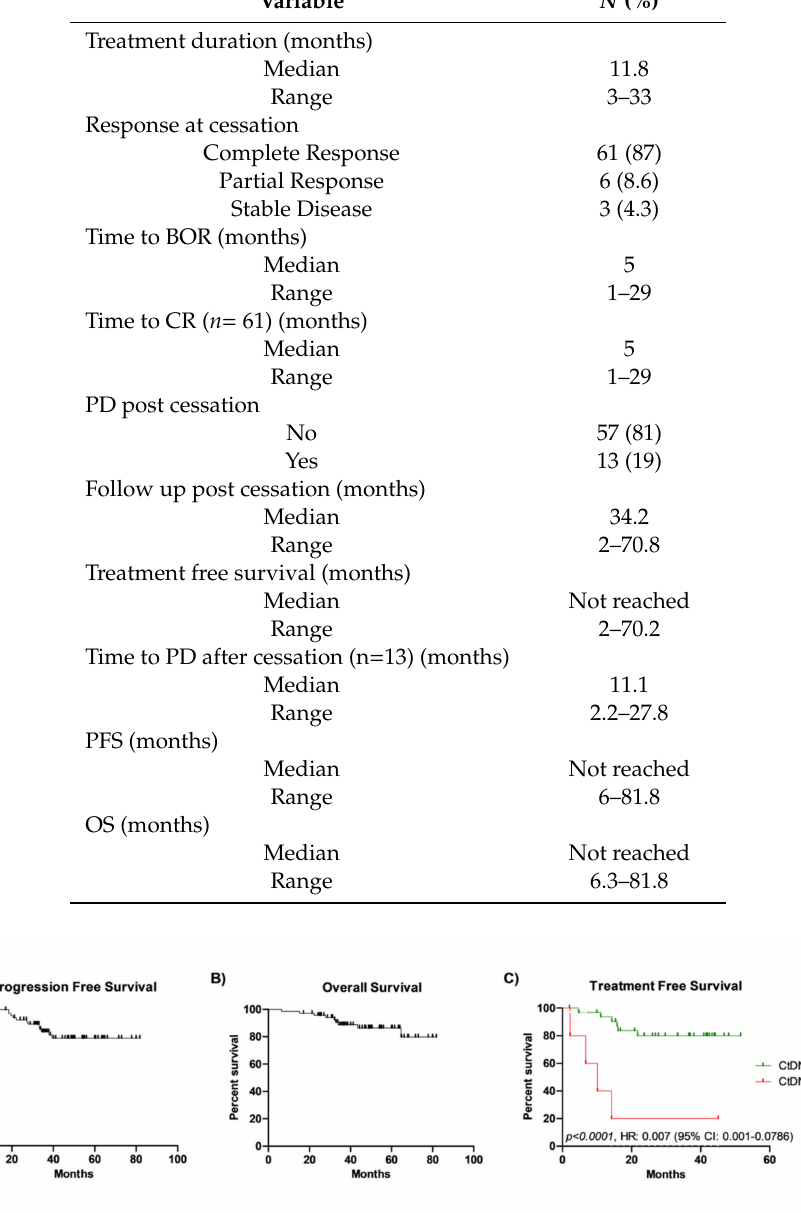
Table 2. Outcome of anti-PD1 antibody treatment ( n =